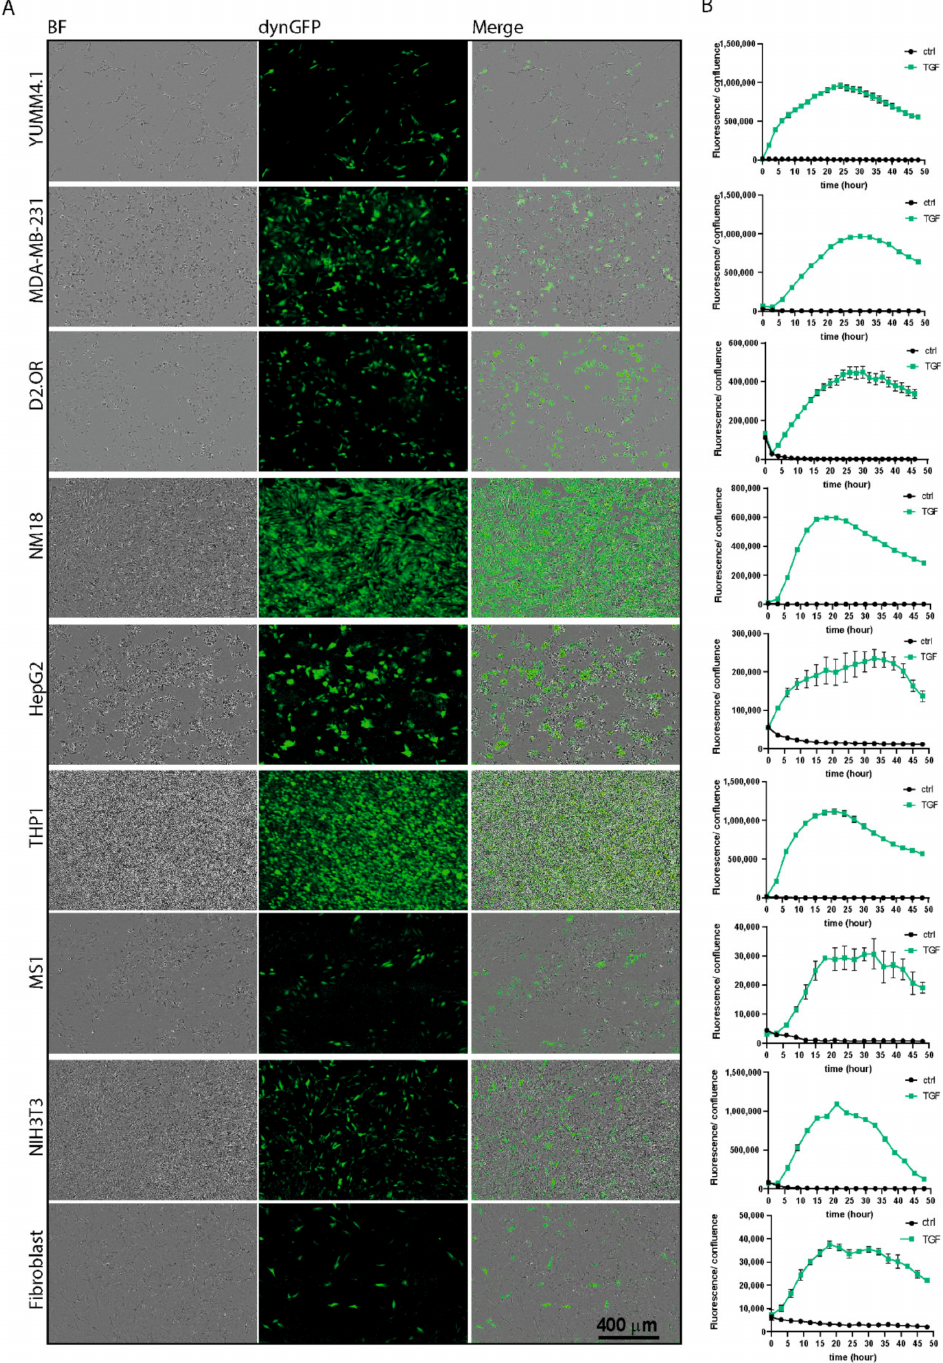
Figure 2. Application of TGF- β /SMAD dynGFP reporter for live cell imaging in different cell lines. ( A ) Cells expressing the pLV.CAGA 12 -dynGFP reporter (mouse normal mammary gland NMuMG derivative (NM18), human liver cancer cells (HepG2), human acute monocytic leukemia cells (THP1, suspension), mouse endothelial (MS1) and fibroblast cell lines (NIH3T3), and human primary fibroblasts) were stimulated with 2.5 ng/mL TGF- β 3 or 1 ng/mL TGF- β 3 (mouse melanoma cells (YUMM4.1), human and mouse breast cancer cells (MDA-MB-231 and D2.OR). Pictures were taken 24 h after stimulation on the Incucyte ® . ( B ) dynGFP signal was measured for 48 h upon addition of control (black) or TGF- β (green) on the Incucyte ® , n ≥ 3. dynGFP fluorescence signal was corrected by confluency (%). Higher background fluorescence during early timepoints on the Incucyte ® results in slightly elevated signals in control